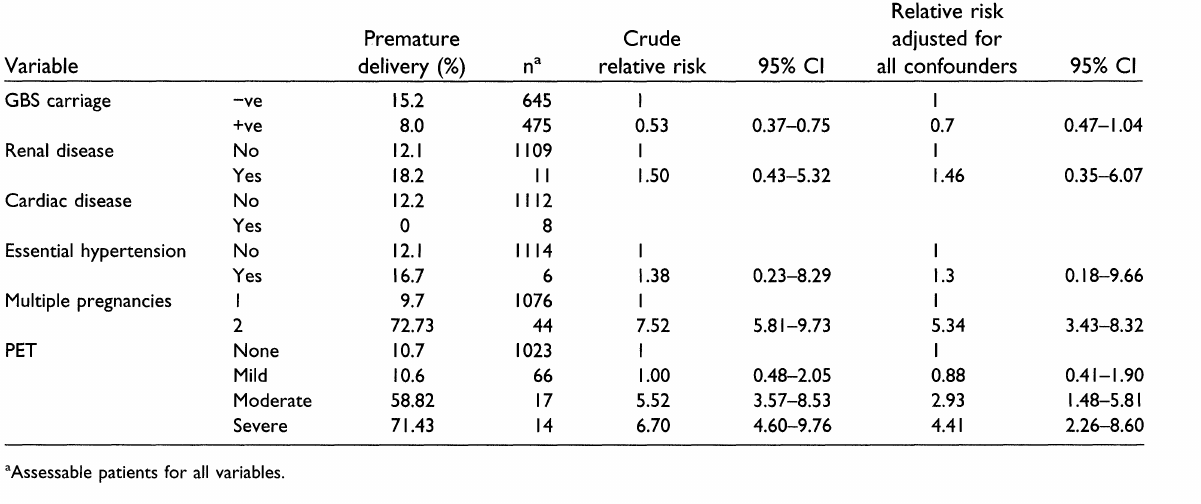
TABLE 2. Univariate and multivariate analyses for the obstetric outcome of premature delivery (by dates) Relative risk Premature Crude adjusted for Variable delivery (%) relative risk